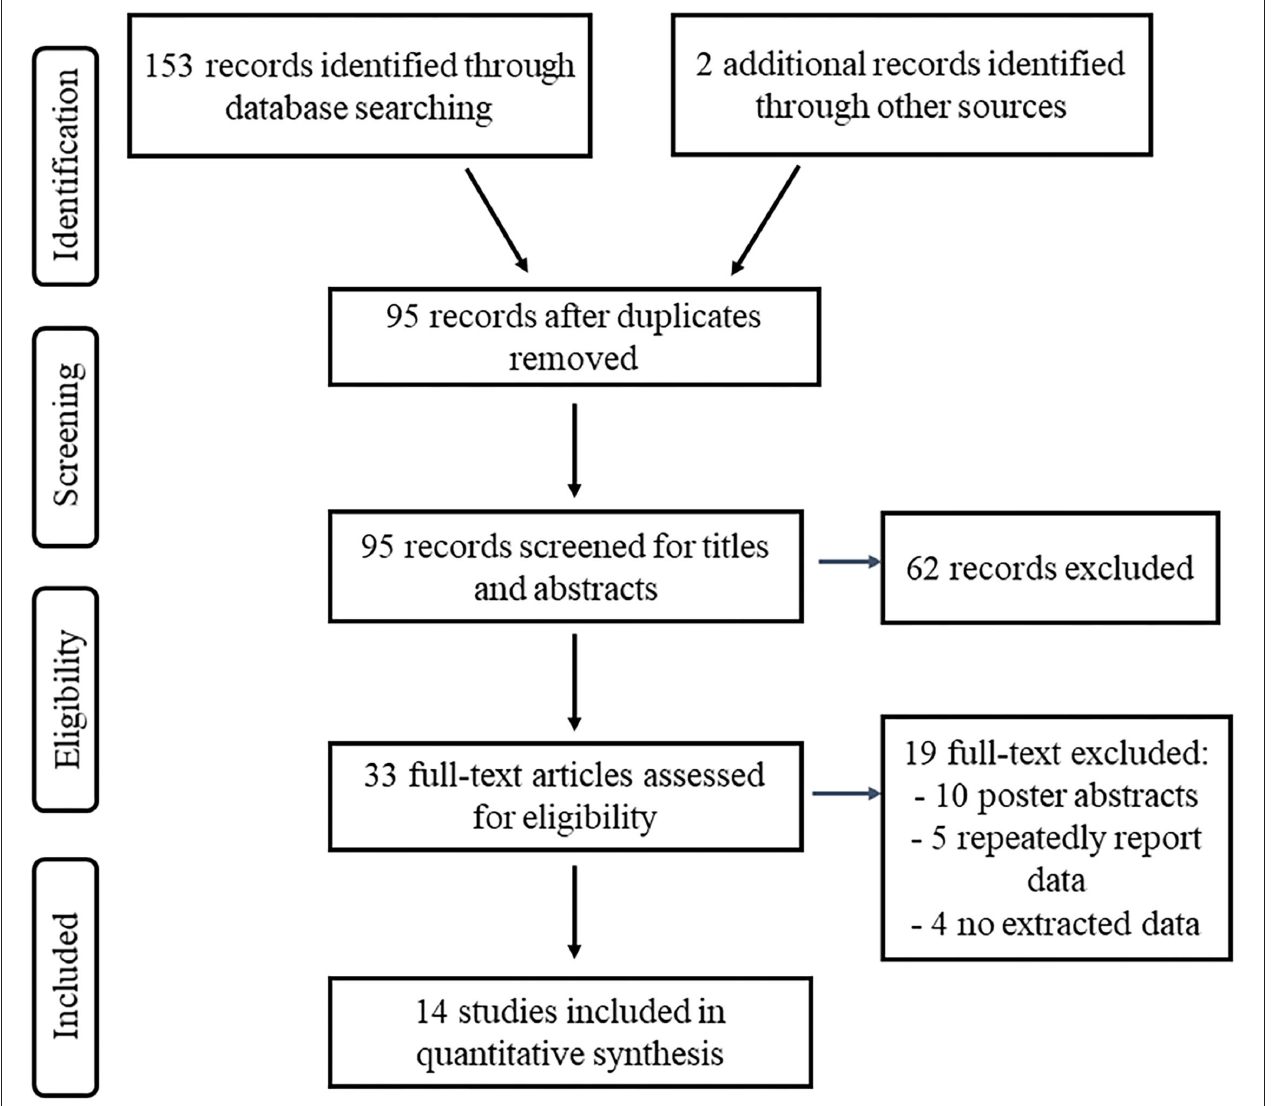
FIGURE 1 | Flow of study information according to PRISMA statement, study selection, and reasons for exclusion.